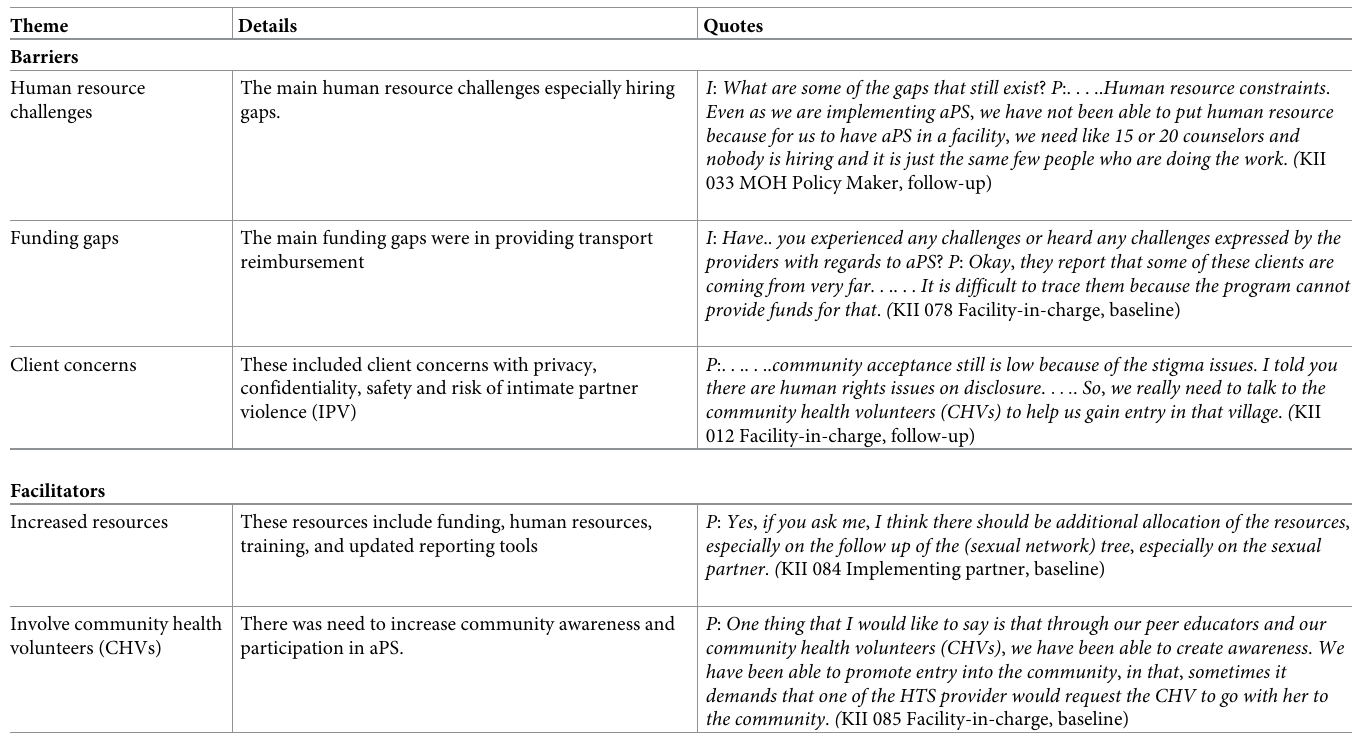
Table 3. Barriers and facilitators to aPS